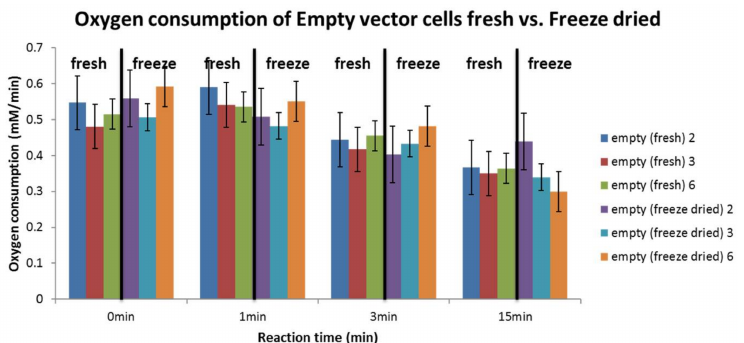
Figure 9. Oxygen consumption rate during the reaction for empty-vector (empty) cells in fresh and freeze-dried preparations at 2 mM